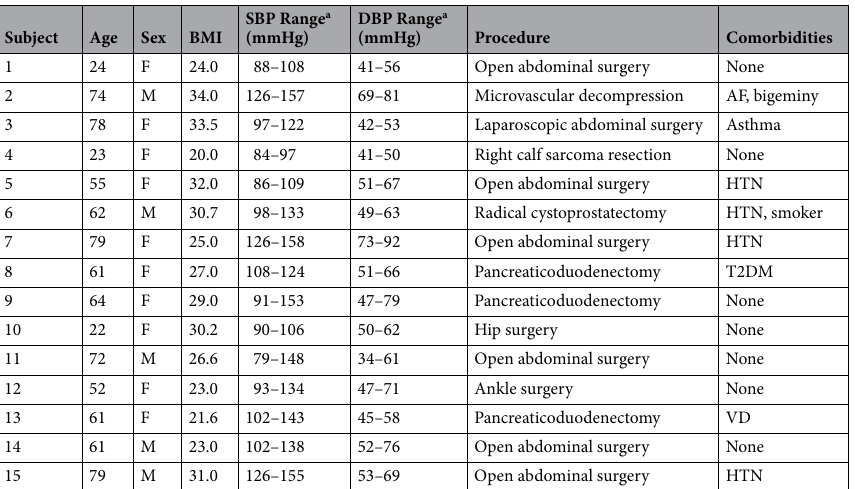
Table 1. Surgical patient demographics. BMI body mass index, SBP systolic blood pressure, DBP diastolic blood pressure, AF atrial fibrillation, HTN hypertension, T2DM type 2 diabetes mellitus, VD vascular disease. a Blood pressure was measured from an arterial line and ranges are representative of the recordings that were tested in this